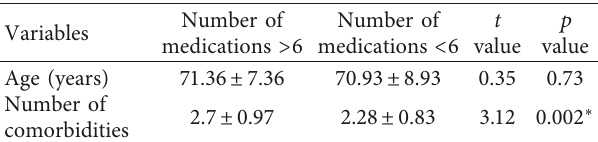
Table 4: Comparison of comorbidities between patients with and without